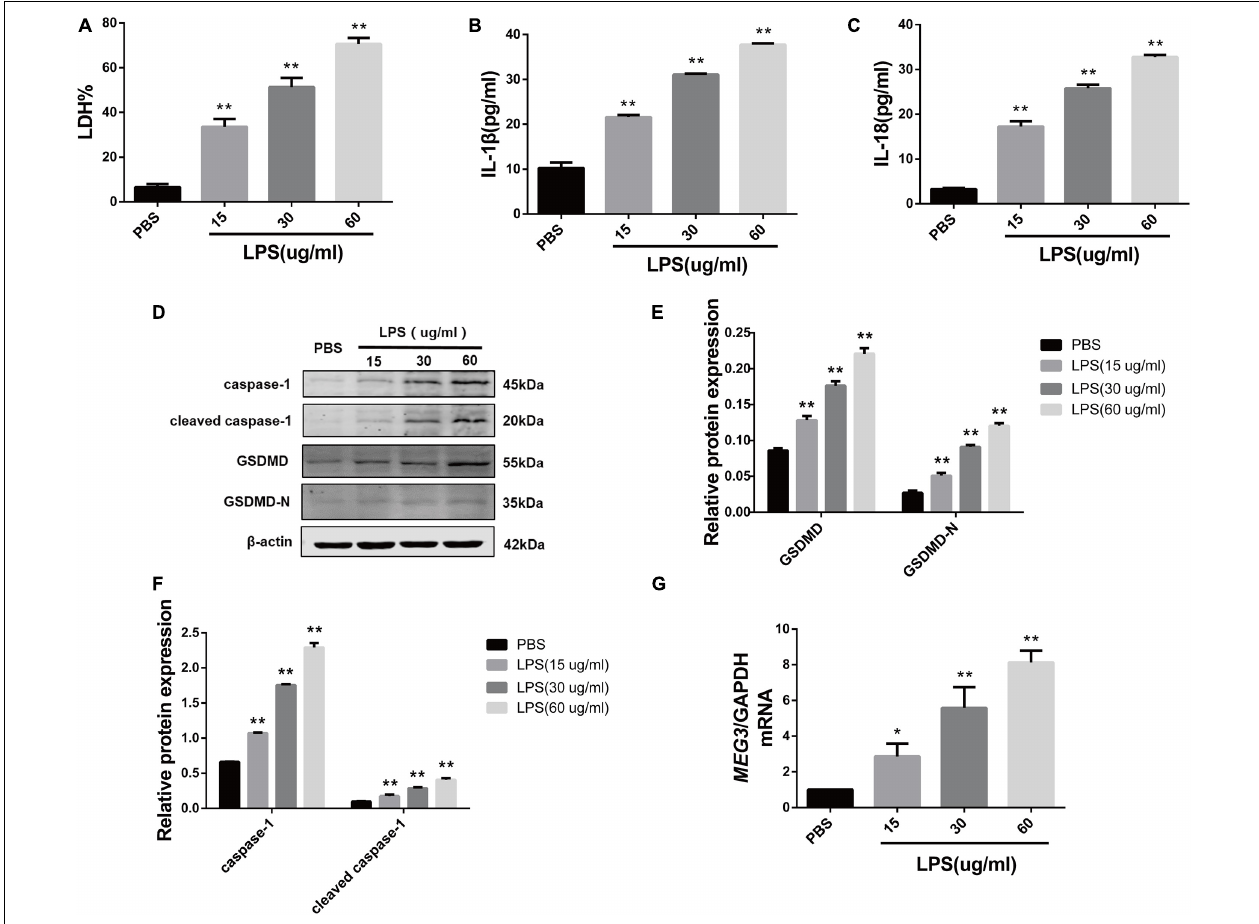
FIGURE 2 | Increased expression of MEG3 in primary human renal tubular epithelial cells treated with LPS. (A) LDH% in TECs supernatants. (B,C) Release of IL-1 β and IL-18 in TECs supernatants. (D–F) Protein expression of caspase-1, cleaved caspase-1, GSDMD, and GSDMD-N in TECs. (G) Expression level of MEG3 mRNA in TECs. * P < 0.05, ** P < 0.01, and compared with the PBS